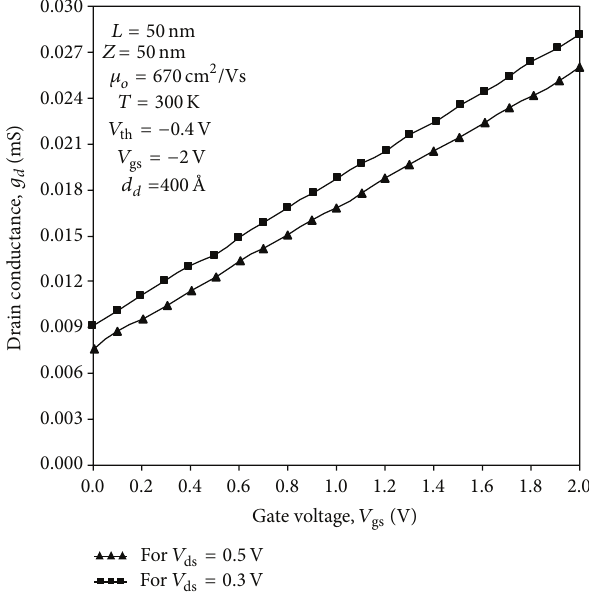
Figure 5: Variation of transit time with gate voltage for different mole